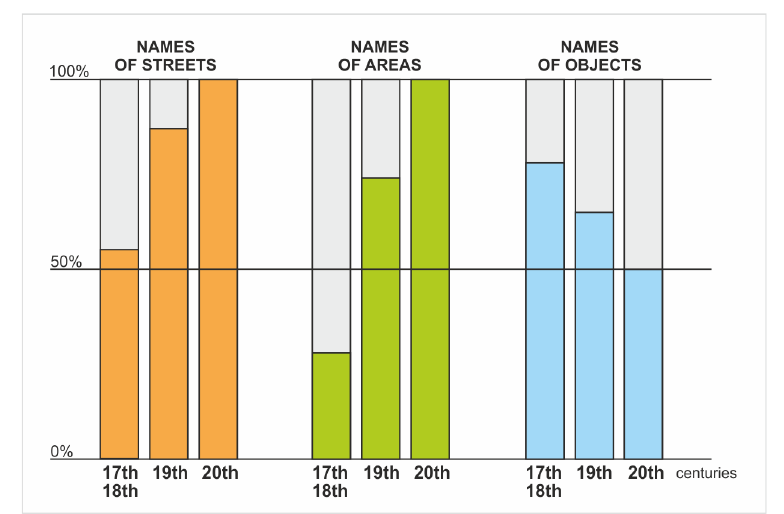
Fig. 1. Percentage of the city maps of Warsaw presenting street, area and object names in the total number of city maps in three periods